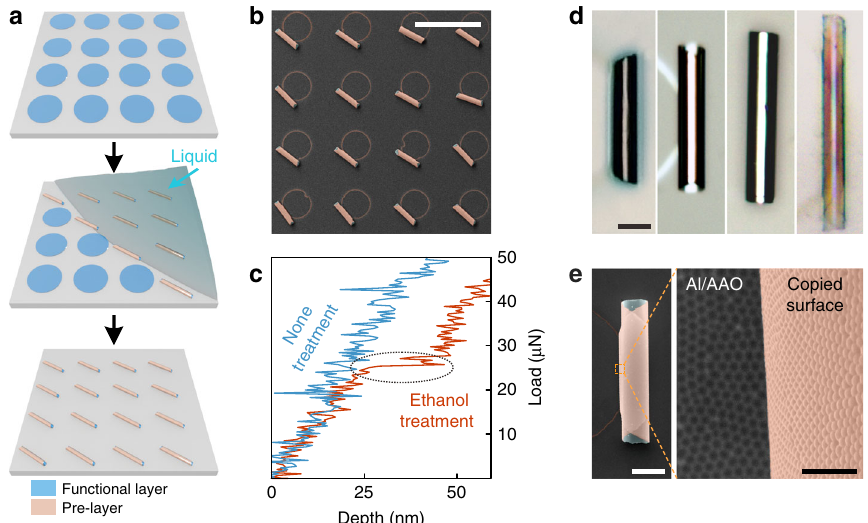
Fig. 1 Versatile 3D rolling construction by liquid-triggered delamination. a Schematic illustration of parallel production of rolling microstructures by one drop of liquid. Patterned nanomembranes are rolled into 3D microstructures as liquid contacts their periphery. b SEM image of an array of Au/SiO/Fe microtubes on glass substrate. Scale bar, 200 μ m. c Nanoindentation of Au nanomembrane on Si substrate with and without ethanol treatment. Adhesion is reduced with ethanol treatment. d Optical images of rolled-up microtubes consisting of different materials. Materials combination from left to right panels are Au/SiO/Fe/Ag on Al, Ag/SiO/Fe on glass, Ti/Cr on glass, and SiO/SiO 2 on Au. Scale bar, 25 μ m. e SEM images of arrayed morphology of rolled-up nanomembrane copied from Al/AAO substrate. Scale bar (left), 20 μ m. Scale bar (right), 500